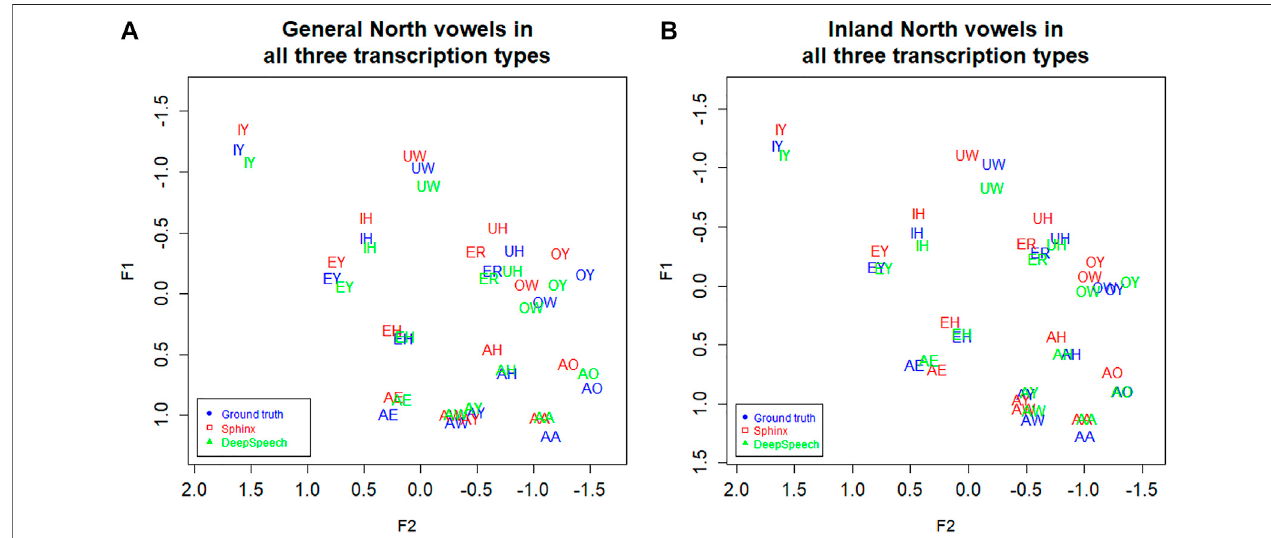
FIGURE 9 | (A) General North and (B) Inland North: speaker vowel means in all three transcription types. Blue: Ground truth (manual) transcription, Red: CMU Sphinx transcription Green: DeepSpeech transcription. 58 speakers and a total of 14,414 vowel tokens. Plotted in Lobanov-normalized units.